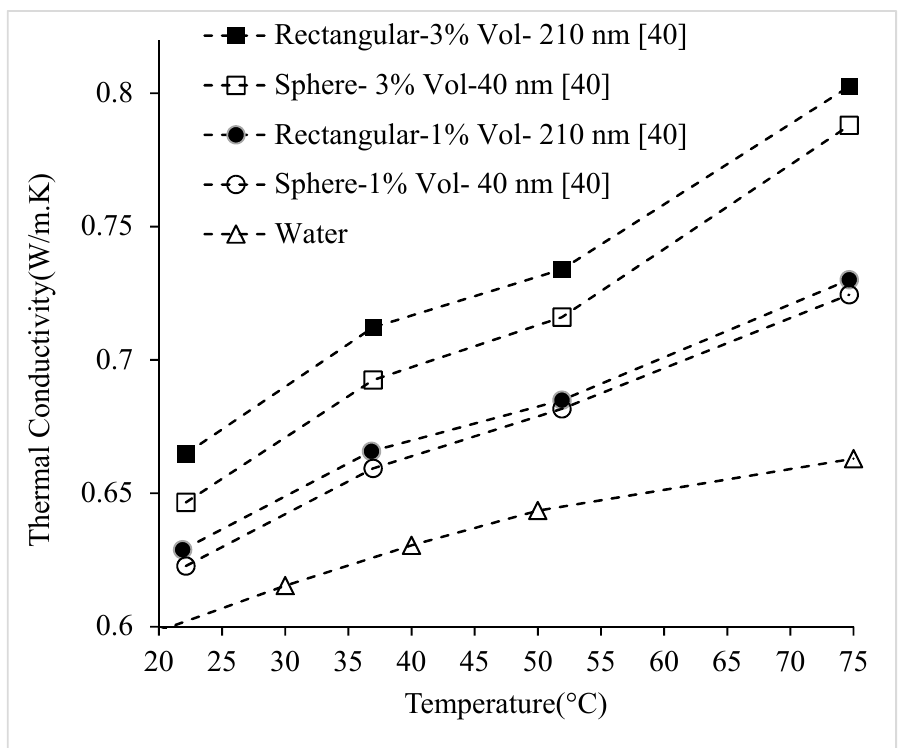
Figure 11. Effect of nanoparticle shape on the thermal conductivity of ZnO–water nanofluid as a function of temperature.